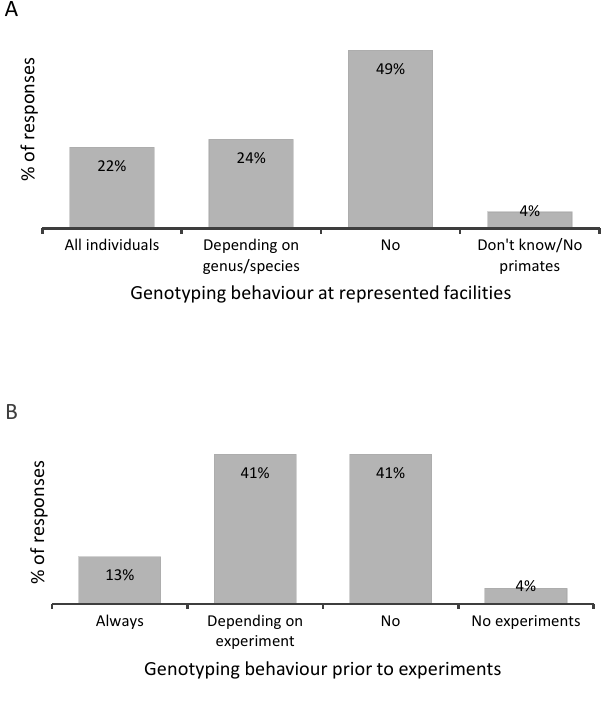
Figure 3. Genotyping behaviour (a) at represented facilities ( N = 45) and (b) before experiments ( N =